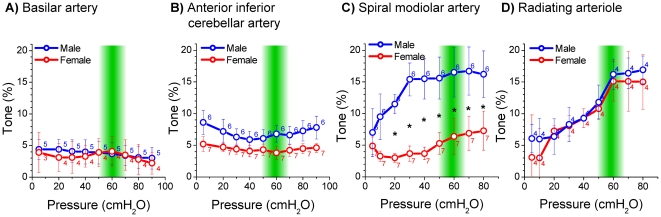
Myogenic tone development along the cochlear vascular tree in male and female gerbil.The myogenic tone at the reference pressure of 60 cmH2O was 4±2% in male (n = 5) and 4±1% in female (n = 4) basilar arteries (A), 7±1% in male (n = 6) and 4±1% in female (n = 7) anterior inferior cerebellar arteries (B), 17±4% in male (n = 6) and 6±3% in female (n = 7) spiral modiolar arteries (C), and 16±2% in male (n = 4) and 15±3% in female (n = 4) radiating arterioles (D). “*” indicates statistical significance (p<0.05) by ANOVA (2-factor repeated-measures).